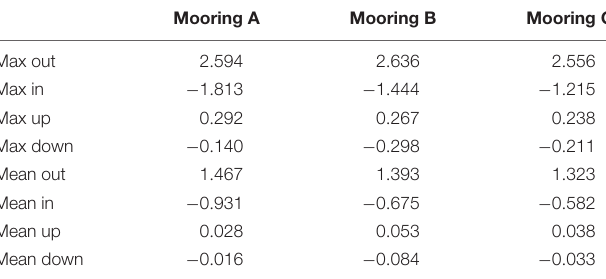
TABLE 3 | Measurement of current velocity at moorings A, B, and